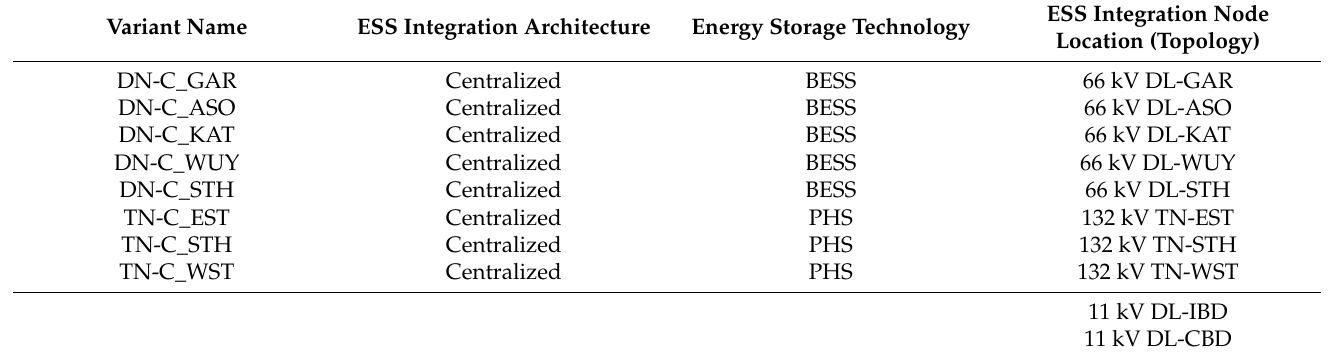
Table 1. Characteristics of Benchmark ESS